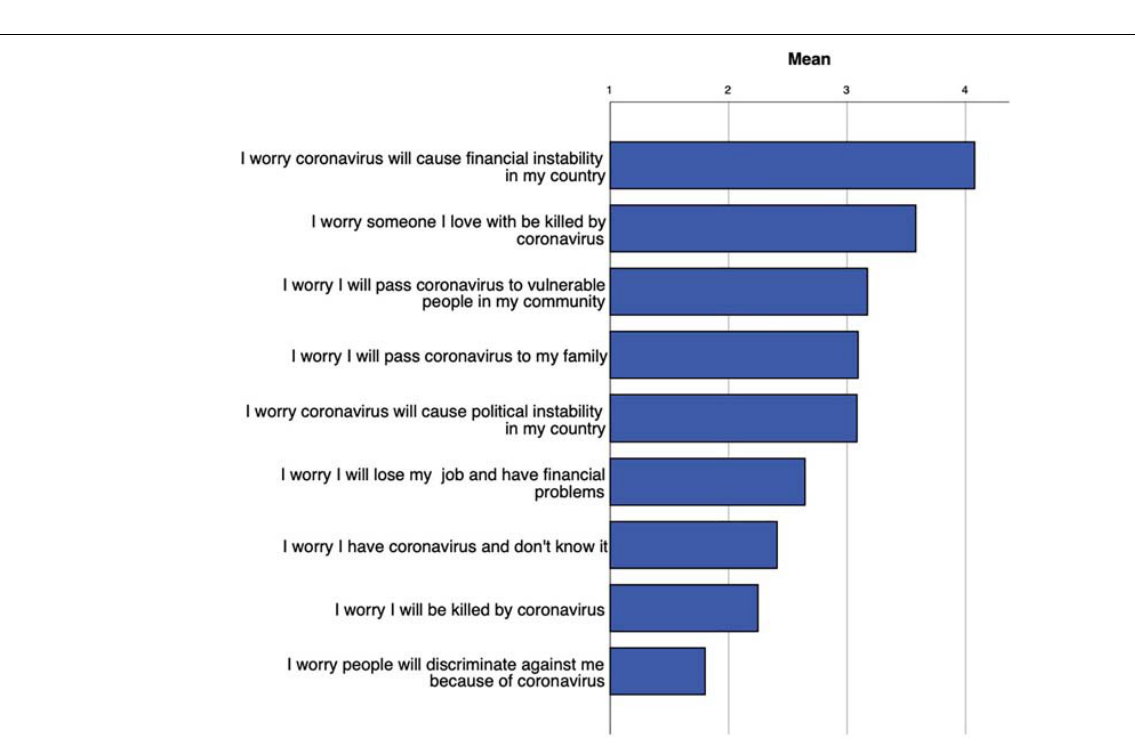
Frontiers in Psychology |